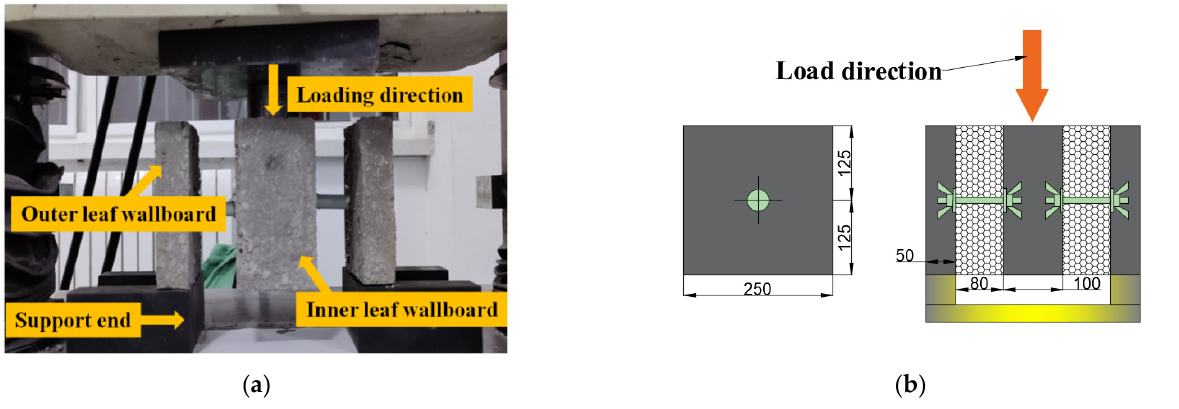
Figure 5. Inner- and outer-leaf wall-panel-reinforcement diagram (Unit: mm).